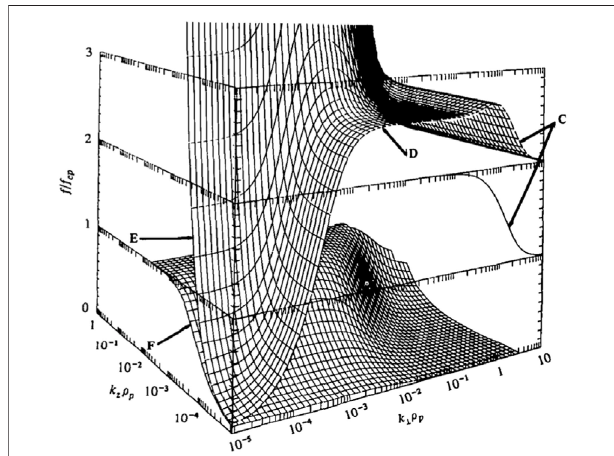
FIGURE1| Dispersion surfaces,wavefrequencyshown asafunctionof wavevector components. Here f and f cp are the wave frequency and the proton gyrofrequency, k ⊥ and k (cid:1) are the wavevector components perpendicularandparalleltothebackgroundmagnetic fi eldand ρ p isthe proton gyroradius. Wave modes include: C) Ion Bernstein waves (also called Ion Cyclotron Harmonic, ICH, waves), D) Lower hybrid waves, E) Right circularlypolarizedwhistlerwaves(fastmagnetosonicorcompressionalAlfvén waves), F) Left circularly polarized shear Alfvén waves (electromagnetic ion cyclotron, EMIC, mode). From André (1985), where details of the plasma model are given.